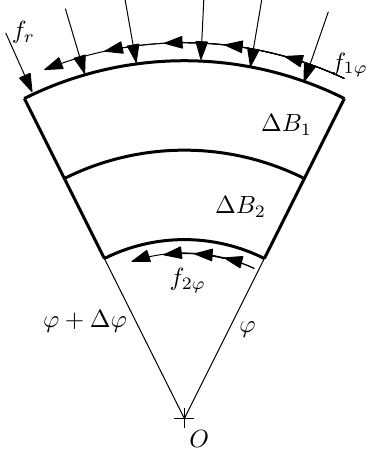
Figure 2: Virtual work of applied forces acting on a small beam ele-